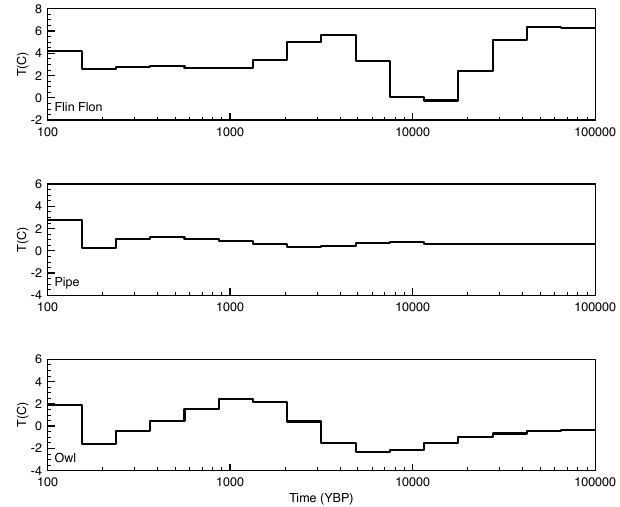
Figure 4. Ground surface temperature history from the Manitoba boreholes at Flin Flon and Thompson (Pipe and Owl). The tem- peratures have been shifted with respect to the reference surface temperature of the site, T o , as shown in Table